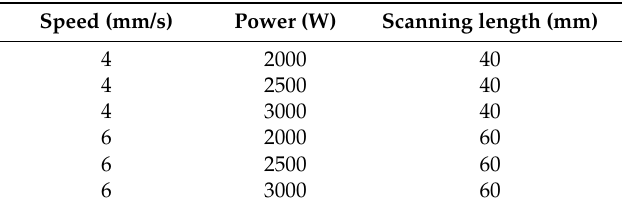
Table 1. Processing conditions for laser heating.